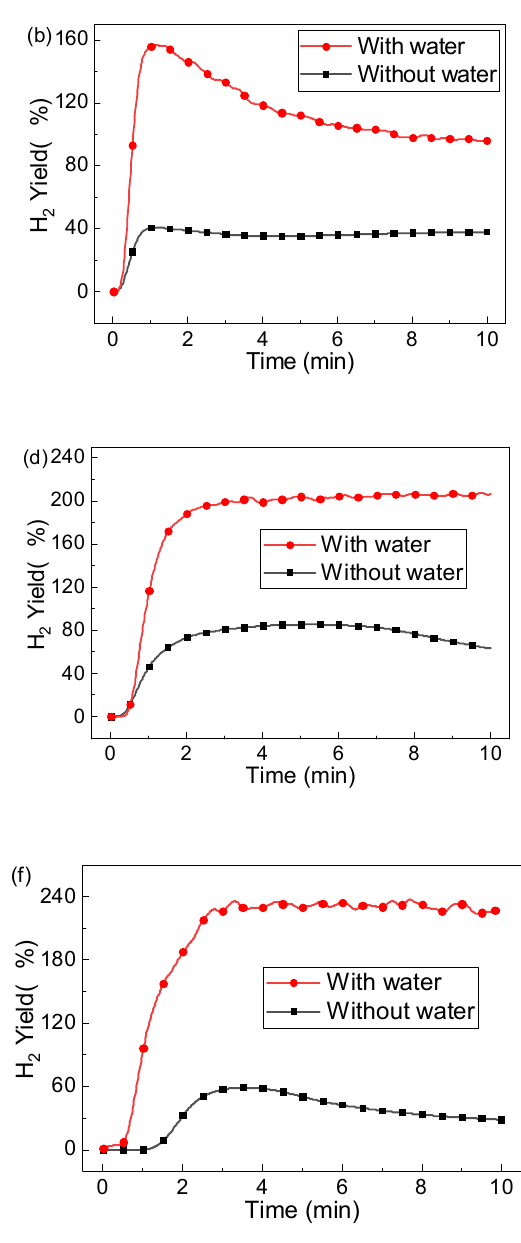
Figure 11. C 1 yield and H 2 yield during chemical looping toluene conversion using different LaFeNi with and without steam at 900 °C: ( a ) C 1 yield and ( b ) H 2 yield for LaFe, ( c ) C 1 yield and ( d ) H 2 yield for LaFe 0.6 Ni 0.4 , ( e ) C 1 yield and ( f ) H 2 yield for LaNi.